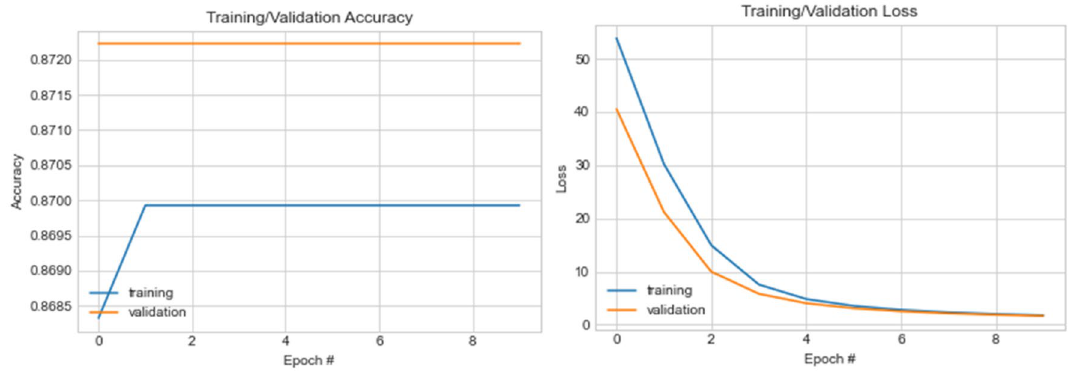
Figure 13. A graphical illustration of accuracy and loss value distribution for ten (10) epochs on the CNN model using normal samples.